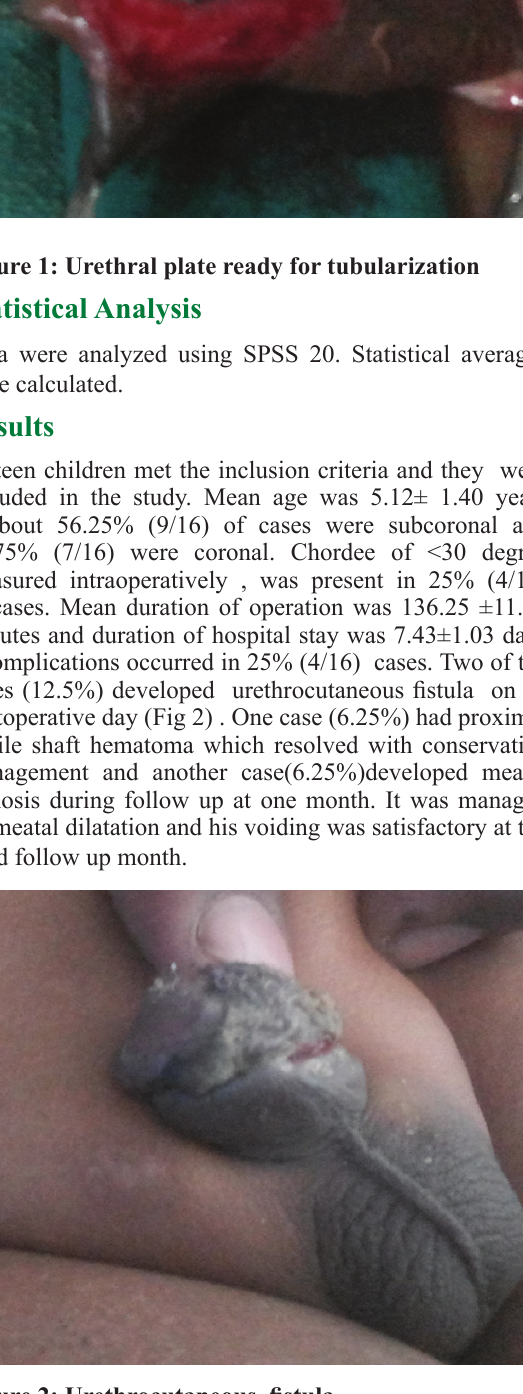
Figure 2: Urethrocutaneous